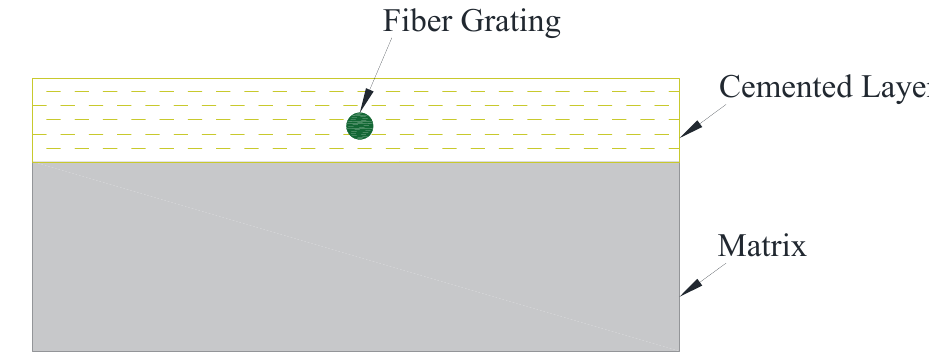
Figure 2. Side view of bare fiber grating adhered to the substrate surface.